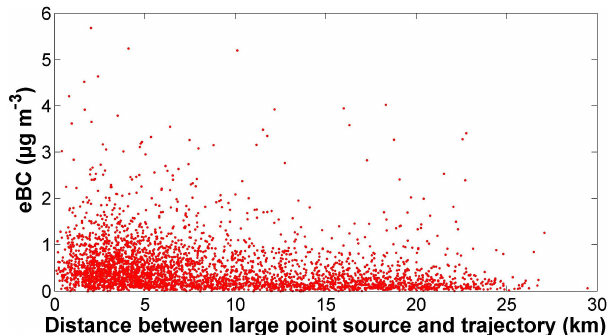
Figure 8. Hourly average eBC concentrations plotted against the shortest distances that hourly arriving back trajectories had passed large point sources during the summer months, i.e. December to February, at Elandsfontein.